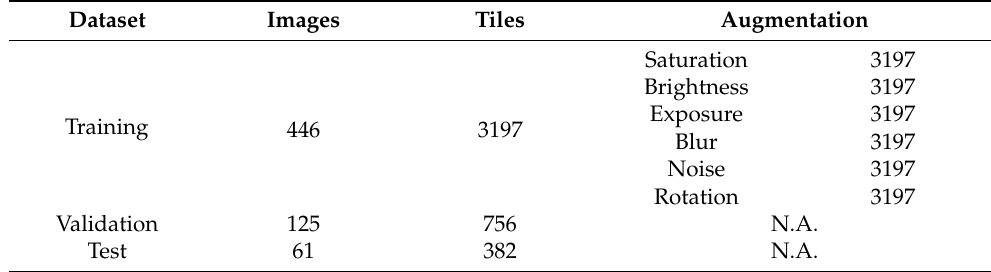
Table 1. Number of images, tiles, and augmentation results per training, validation, and test sets. Dataset Images